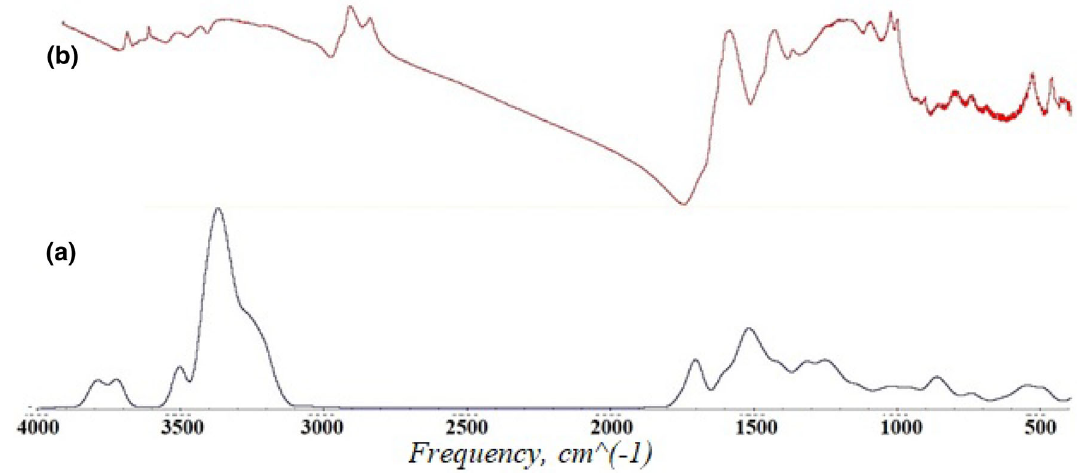
Fig. 3 a IR-spectrum of 3D model of coal organic mass, b experimental IR-spectrum for DG coal grade